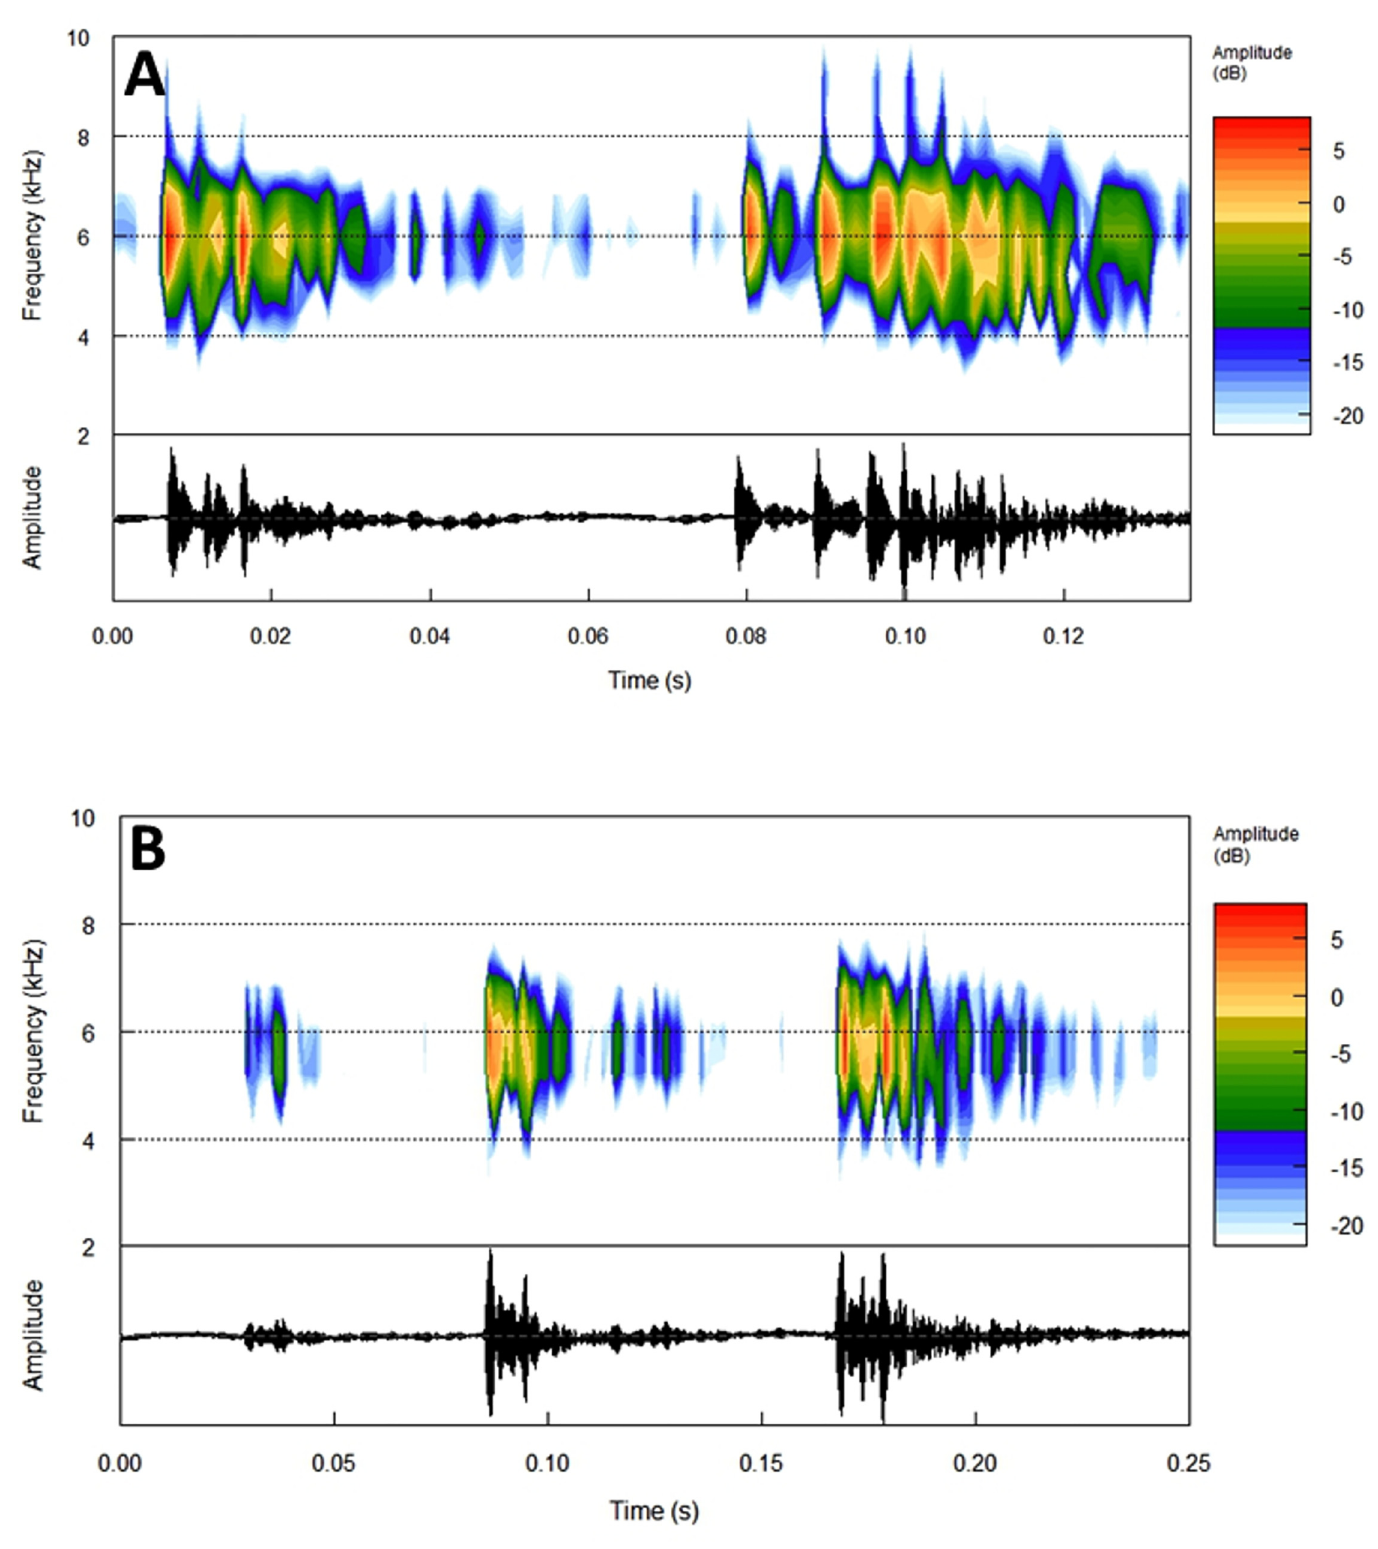
Fig 4. Calls of Dendropsophus bromeliaceus sp. nov.. (A) Advertisement call and (B) territorial call with spectrogram (above) and oscillogram (below) (MNVOC 048/01-06). Air temperature was around 23.2°C.